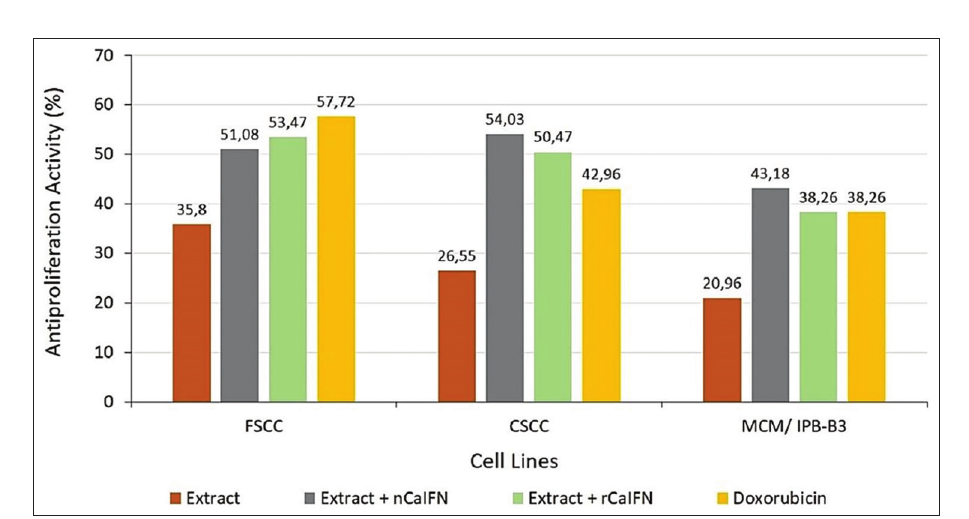
Figure-2: Antiproliferation activity of combination between Typhonium flagelliforme leaves ethanol extract with natural canine interferon and recombinant canine interferon on feline squamous cell carcinoma, canine squamous cell carcinoma, and MCM/IPB-B3 tumor-derived cell lines.